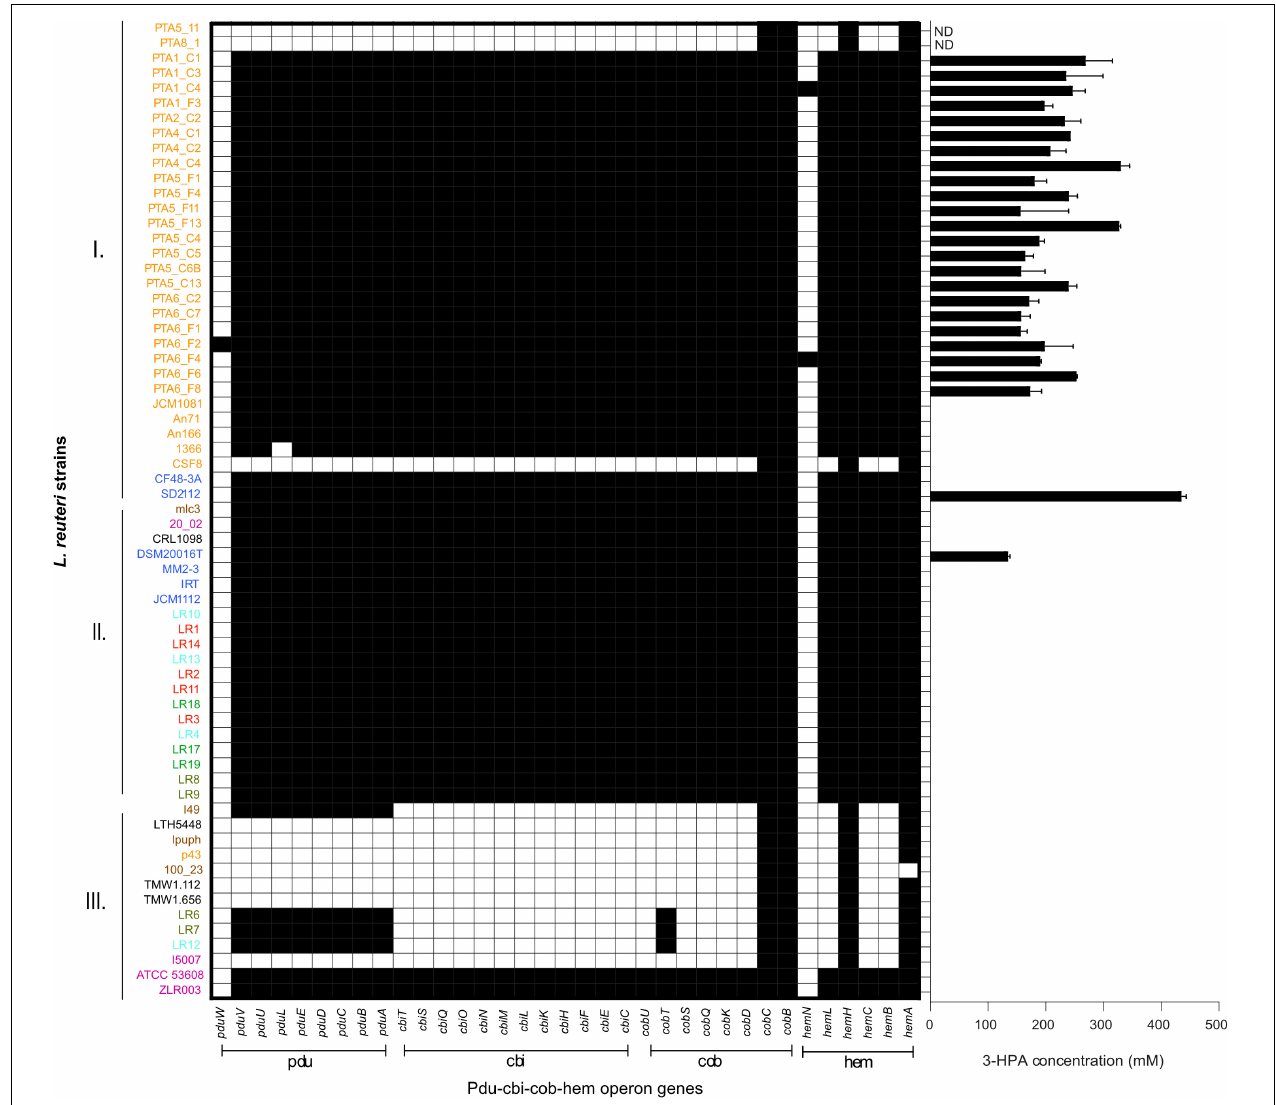
FIGURE 5 | Reuterin operon genes ( pdu-cbi-cob-hem ) detected in the genomes of 65 L. reuteri listed in Supplementary Table S1 and 3-HPA production of 25 strains isolated from chicken in this study. Black indicates the presence of a gene. Different colors represent different hosts, blue: human; yellow: chicken; pink: pig; brown: mouse/rat; light blue: cow; red: goat; green: horse; brown/green: sheep; black: sourdough. ND not determined.